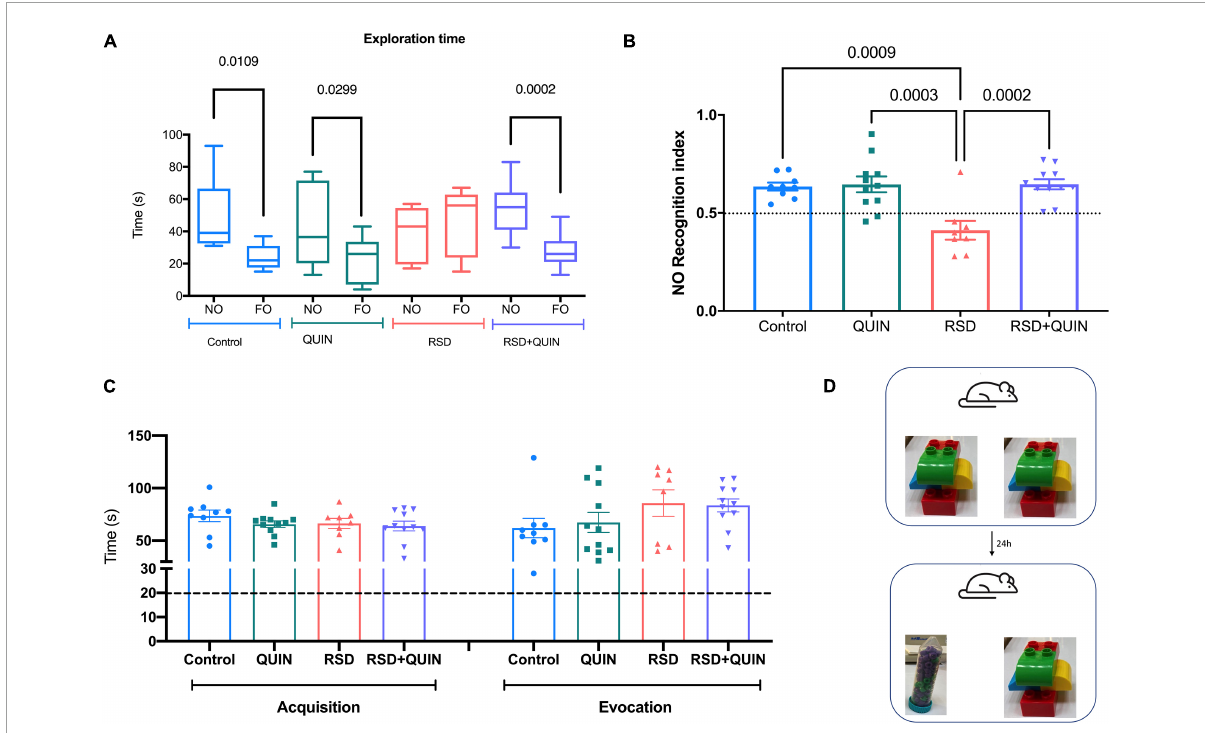
FIGURE5 Rapid eye movement (REM) sleep deprivation (RSD) for 72 h impaired recognition memory performance, and Quinpirole (QUIN) attenuated this effect. Data are shown as the (A) novel and familiar object exploration time, (B) Recognition index of the Novel object recognition test (NOR-RI), (C) total exploration times of both objects in acquisition and evocation, and (D) objects used in the acquisition and evocation test. Mice were administered QUIN (2 mg/kg for 3 days) and subjected to RSD. Data are presented as the mean ± SEM and were analyzed using